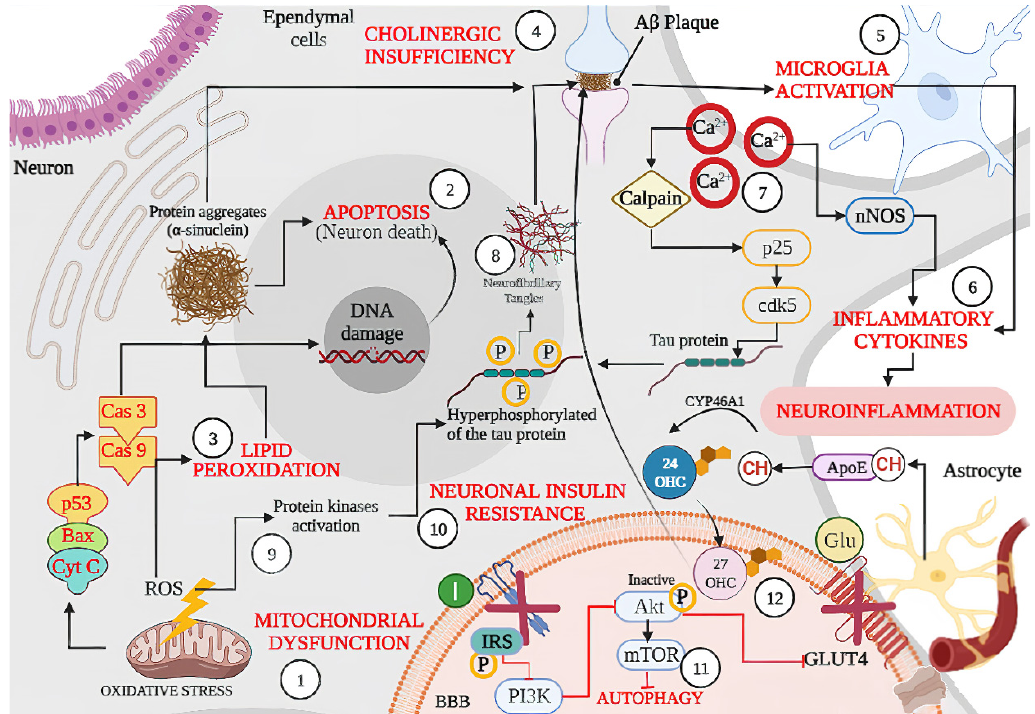
Figure 2. Schematic representation of shared physiopathological hallmarks in neurodegenerative